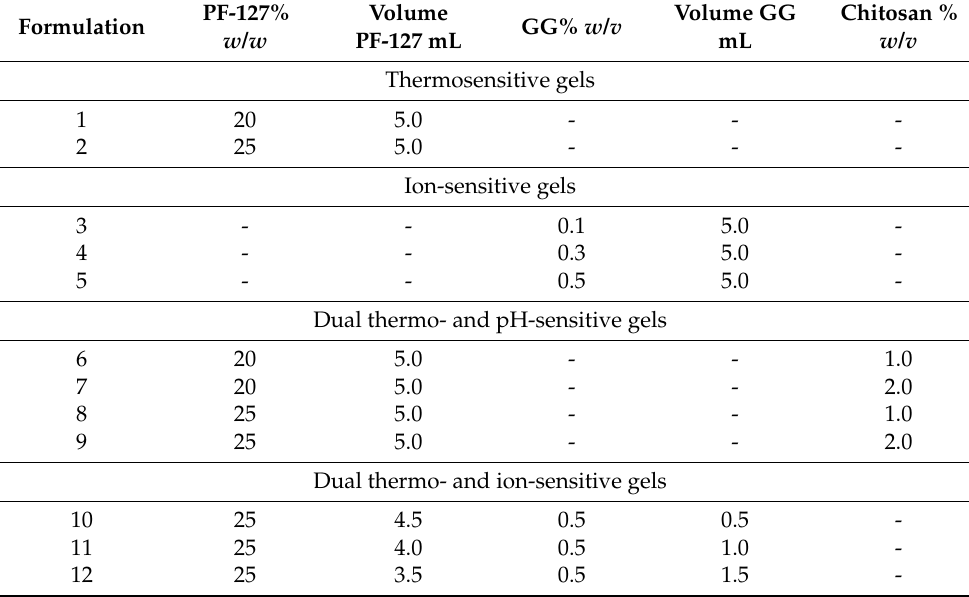
Table 2. Composition of stimuli-responsive carriers tested.